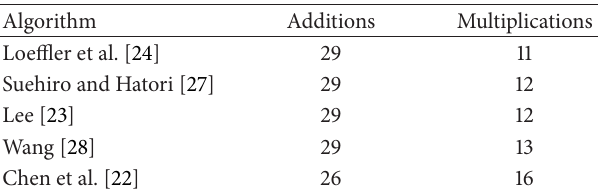
Table 1: Number of arithmetic operations for 8-point DCT compu- tation of some well-known